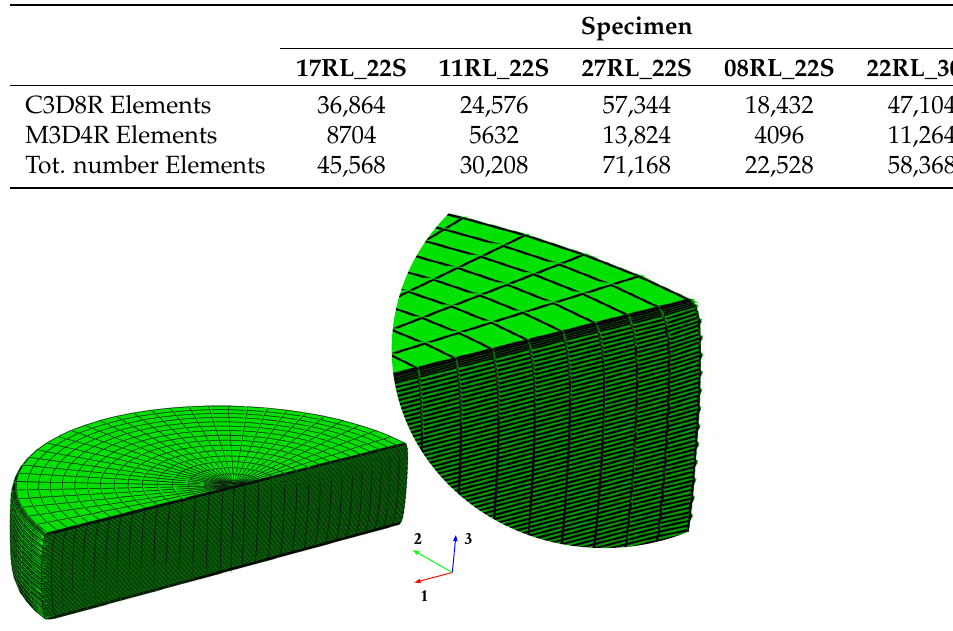
Table 2. Number of elements of the virtual experiment specimens.